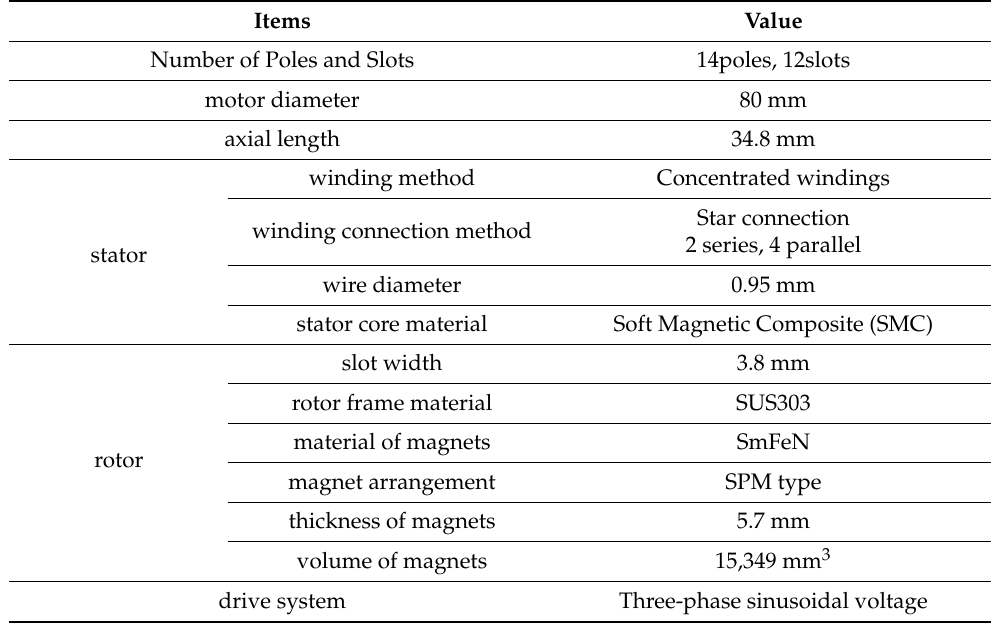
Table 5. Specifications of prototype axial-gap motor.